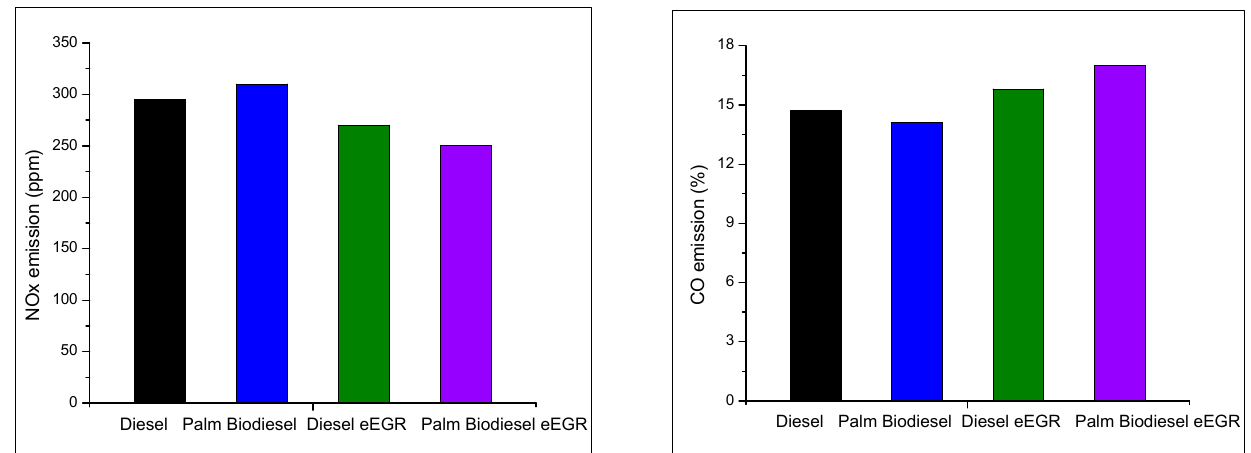
Figure 7. A comparison of the effect of eEGR rate on BSFC and exhaust gas temperature between diesel and palm oil biodiesel.